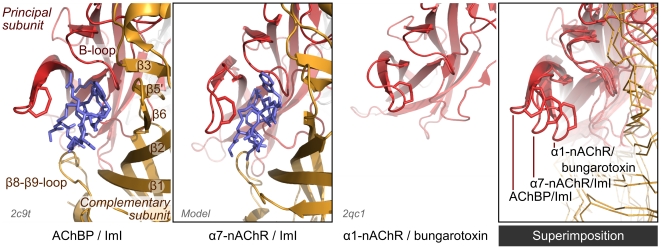
Comparison of the binding site of AChBP/ImI complex (PDB ID: 2c9t), α7-nAChR/ImI complex (model, this work) and α1-nAChR/bungarotoxin complex (PDB ID: 2qc1).In the α1-nAChR/bungarotoxin structure, only one subunit was crystallized, and the bungarotoxin is not shown. The model displaying α7-nAChR was obtained by a combination of comparative modeling and molecular dynamics, and the displayed conformation corresponds to energetically minimized frames after 10 ns of simulations. The C-loop, the principal subunit, and the complement subunit are indicated. In the three first panels and from left to right, the conformation of the C-loop increasingly reduces the volume of the binding site. The fourth panel, on the right, shows a superimposition of the AChBP and nAChR subunits, highlighting the different C-loop conformations between the model and the two experimental templates.